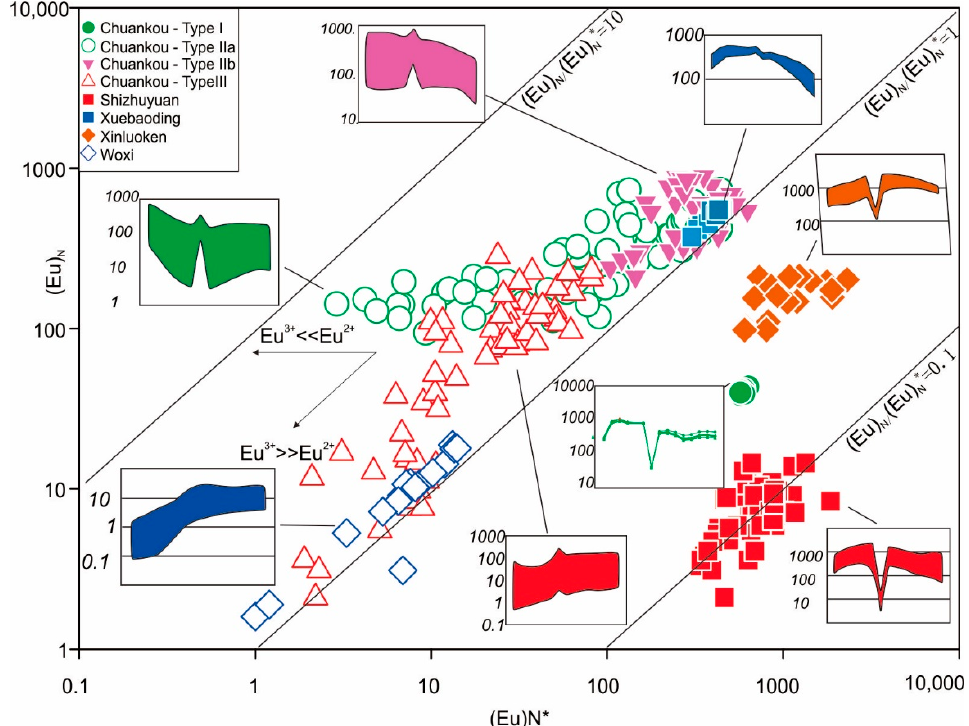
Figure 10. Plot of chondrite-normalized concentrations (Eu) N versus calculated Eu value (Eu) N *, for scheelites analyzed in this study. Chondrite values are from Sun and McDonough [39].